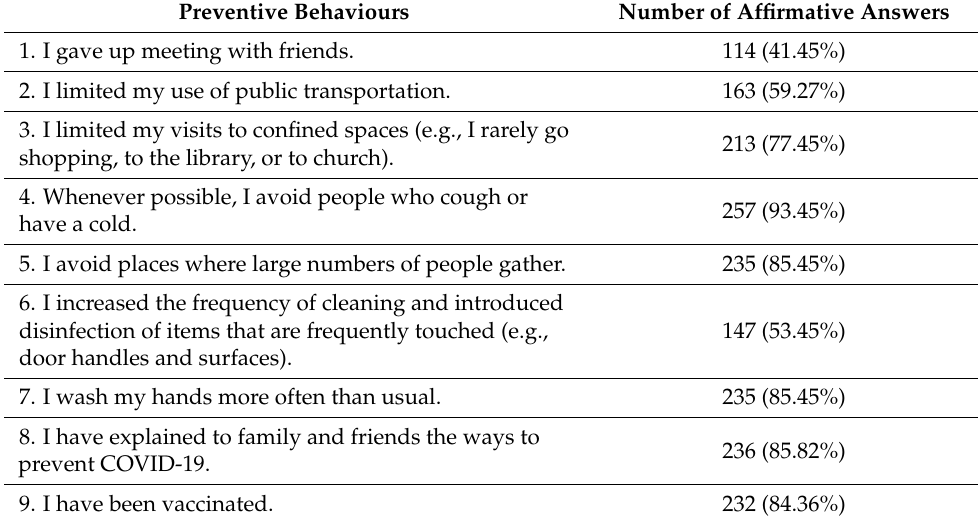
Preventive behaviour among students of nursing, midwifery, and emergency medical